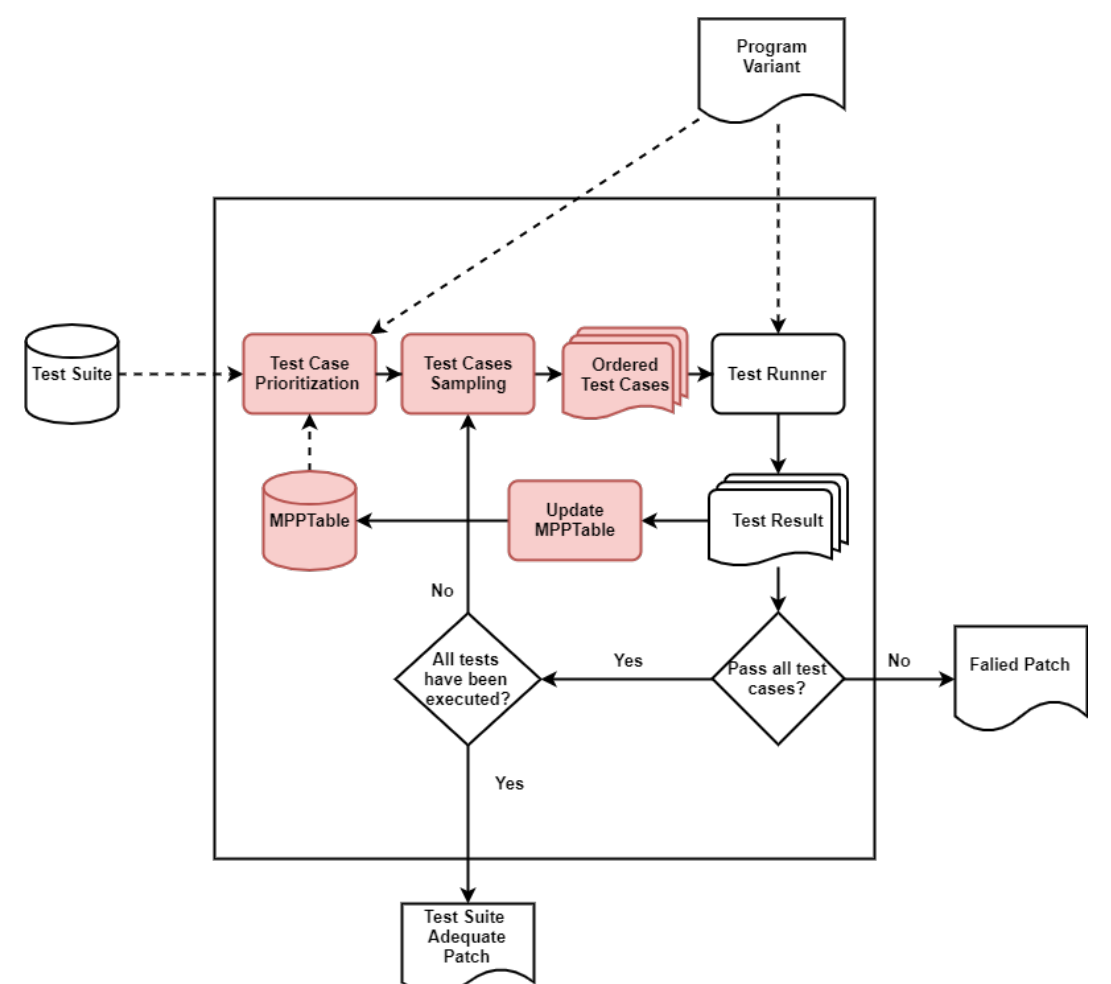
Figure 2. Modification Point-aware Test Prioritization (MPTPS)